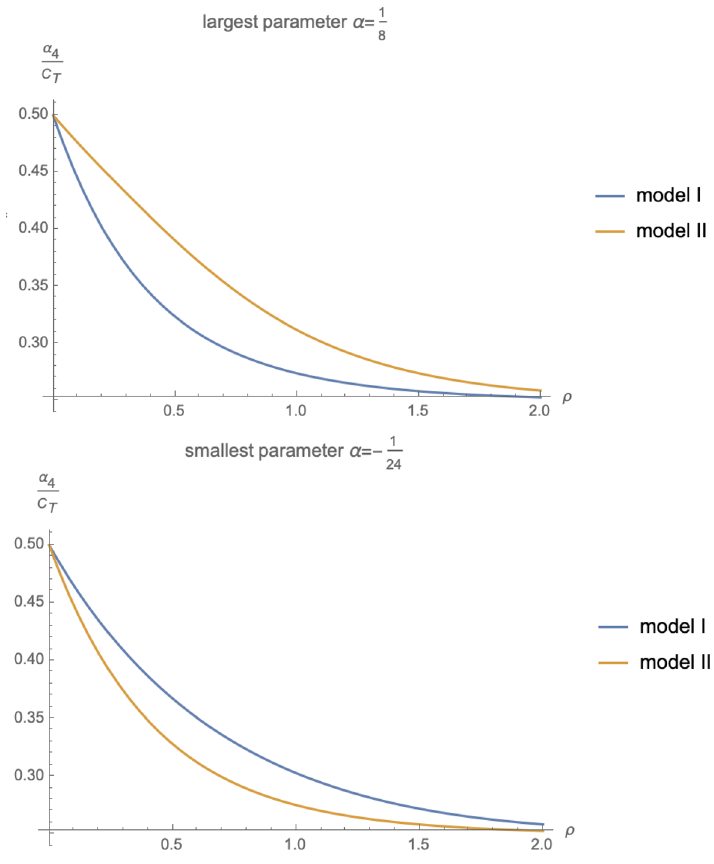
Figure 5 . Casimir coefficient α 4 for the largest parameter α = 1 parameter α = − 1 (below). The blue line and orange line correspond to model I of section 3.2 24 and model II of section 3.3, respectively. The Casimir coefficient α d is positive and decreases with the brane tension ρ